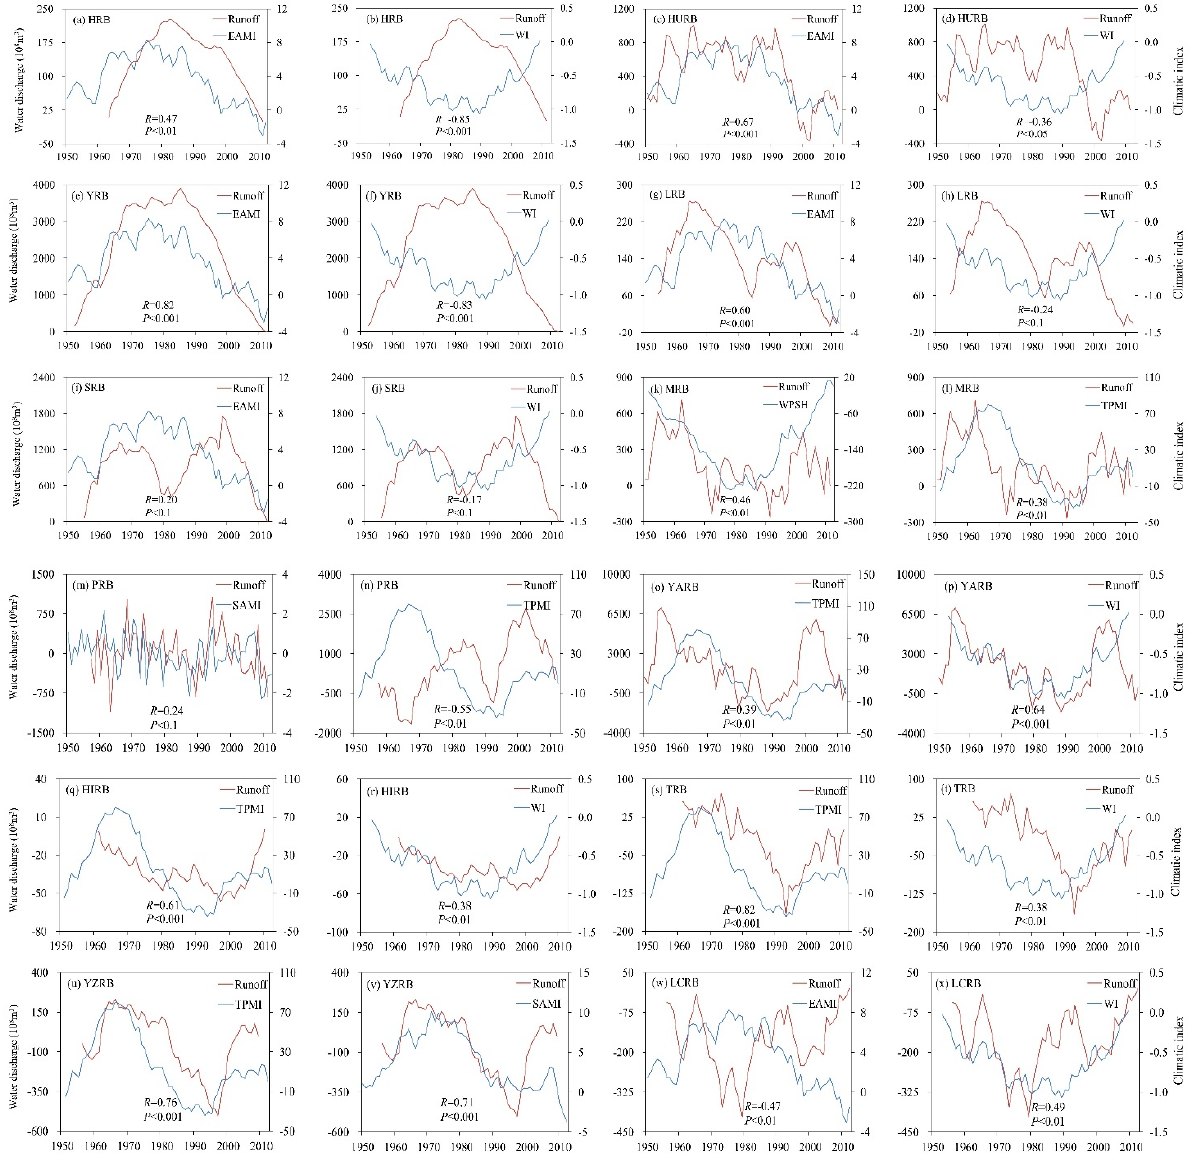
Figure 7. Cumulative anomaly curves of streamflow versus monsoon intensity indices in the main basins of China. EAMI, SAMI, WI, WPSH and TPMI represent the East Asian monsoon index, westerly index, West Pacific subtropical high, and Tibetan Plateau monsoon index, respectively. R and P represent the correlation coefficient and significance level,